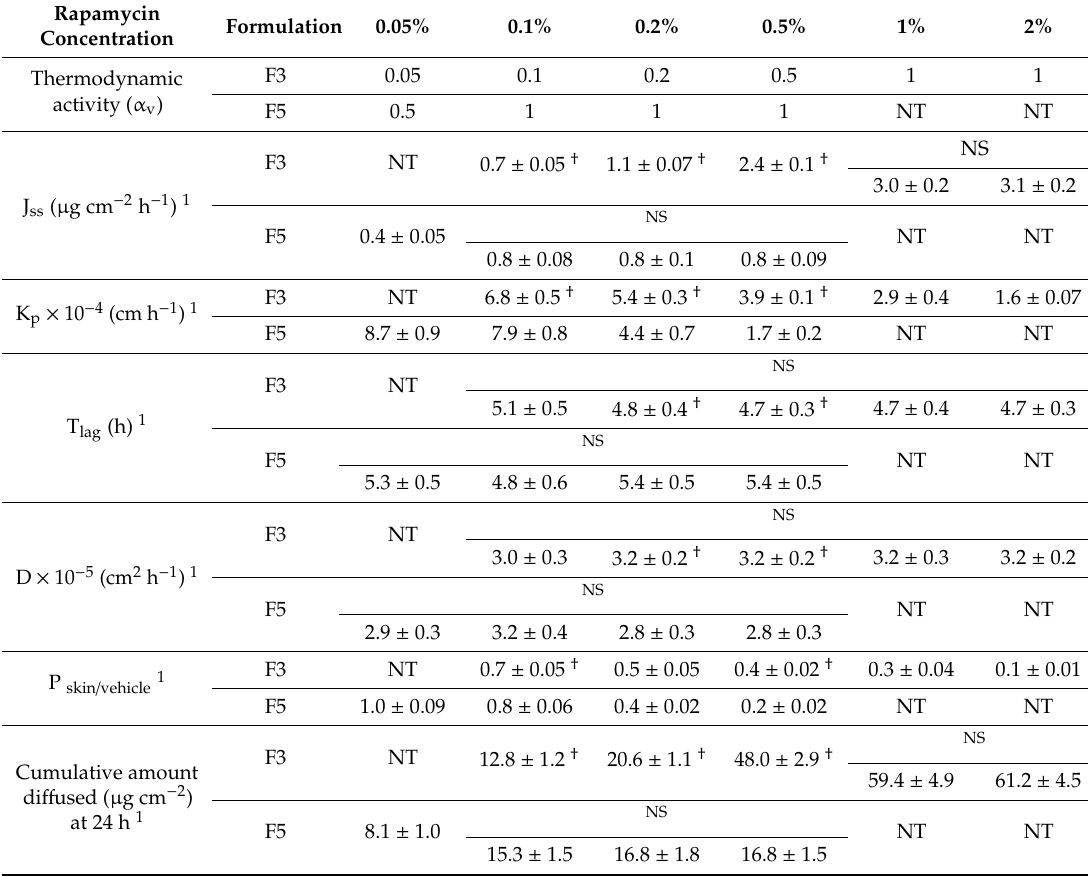
Table 5. E ff ect of rapamycin concentration on permeation parameters from formulations F3 and F5.